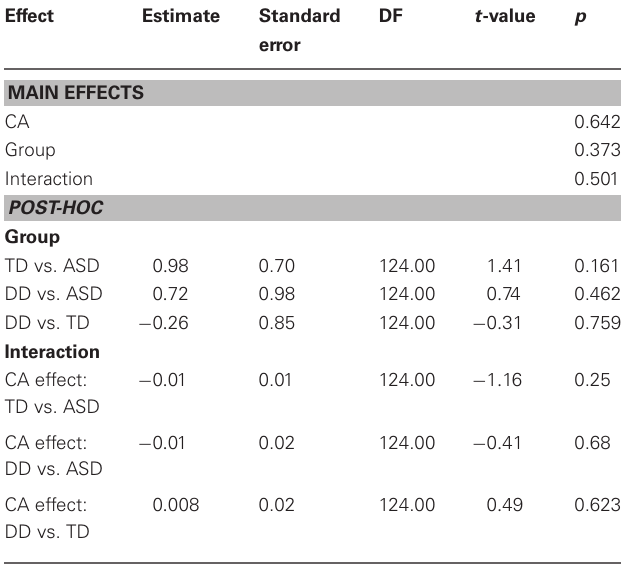
Table 7 | Grip force at onset of load force and chronological age